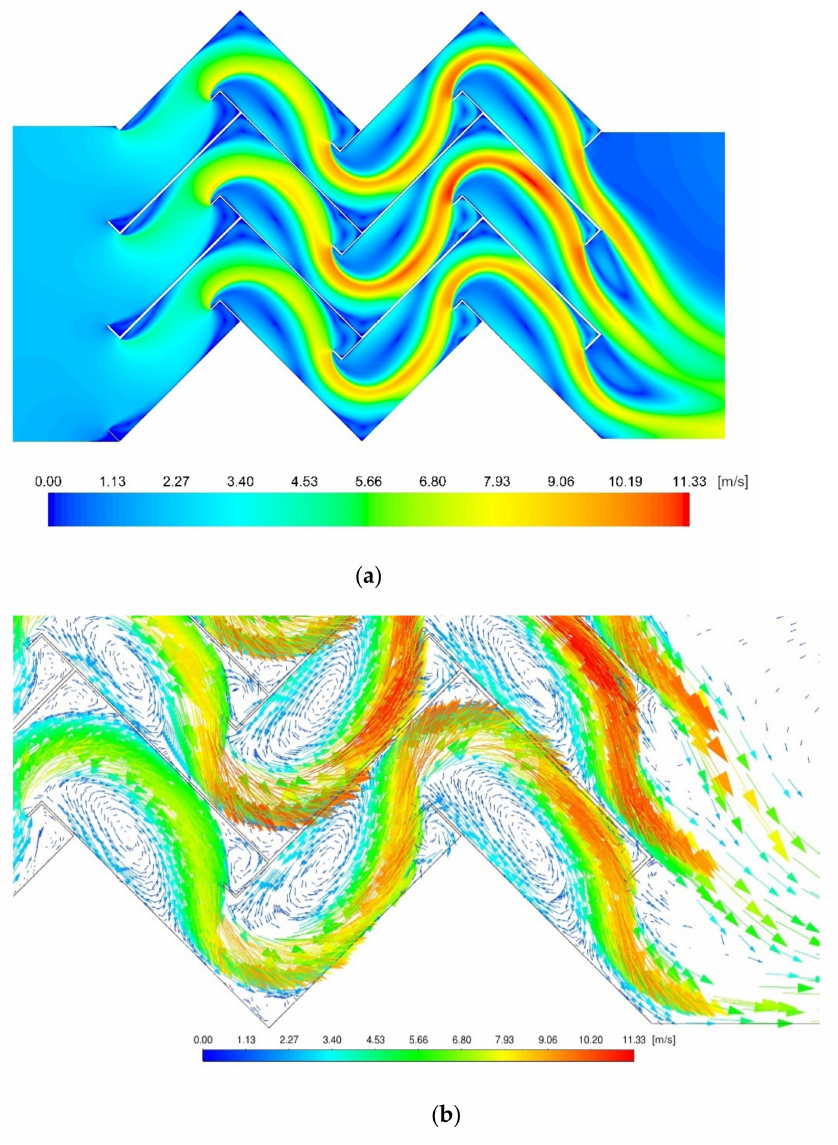
Figure 20. Velocity fields ( a ) and vectors ( b ) (m s − 1 ) ( a ) and vectors ( b ) (m s − 1 ) of geometry variant B_15_0 with inlet velocities 2 m s − 1 simulated using a transition SST model. Analysing the velocity distributions of the considered cases for 2 m s − 1 , one can observe that the new geometry gets higher maximum velocities than the corresponding variant with non-streamlined drainage channels. This phenomenon is related to the shape of the external drainage channel walls. In C_15_0, the main gas stream is flattened, which is mainly visible on the third channel flows. A critical phenomenon is the occurrence of vortexes inside the channels. In the case of simple channels, the vortex is flattened in an oval shape. Around the channel’s edges, the fluid from inside comes into contact with a gas with a nearly maximum velocity. Although, in the case of the profiled channels, a different phenomenon occurs. The forming vortex is round in shape, and the channel’s edge disturbs the flow to a lesser extent, which will substantially impact the entrapment of deposited droplets—this can be well observed analysing the droplet trajectories presented in Figures 21 and